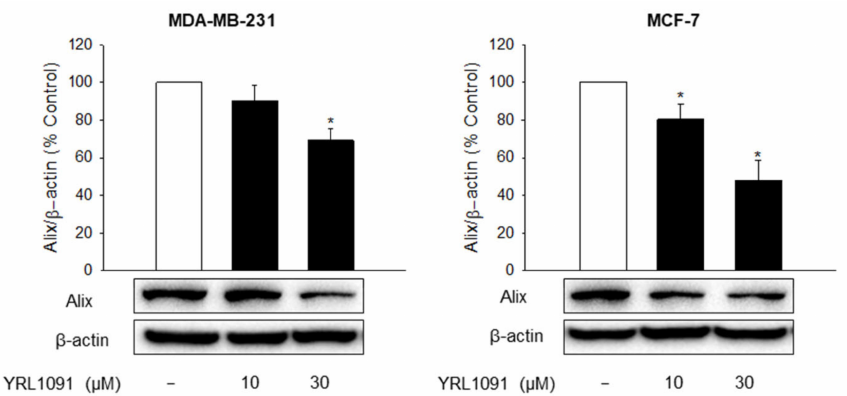
Figure 4. Effect of YRL1091 on the expression of Alix protein in MDA-MB-231 and MCF-7 cells. Cells were treated with YRL1091 at 10 and 30 µ M for 24 h. The levels of Alix were measured by western blotting. Each data point was calculated as the percentage of protein level in vehicle-treated control cells. Representative bands from at least three independent experiments were shown. * p < 0.05 vs.